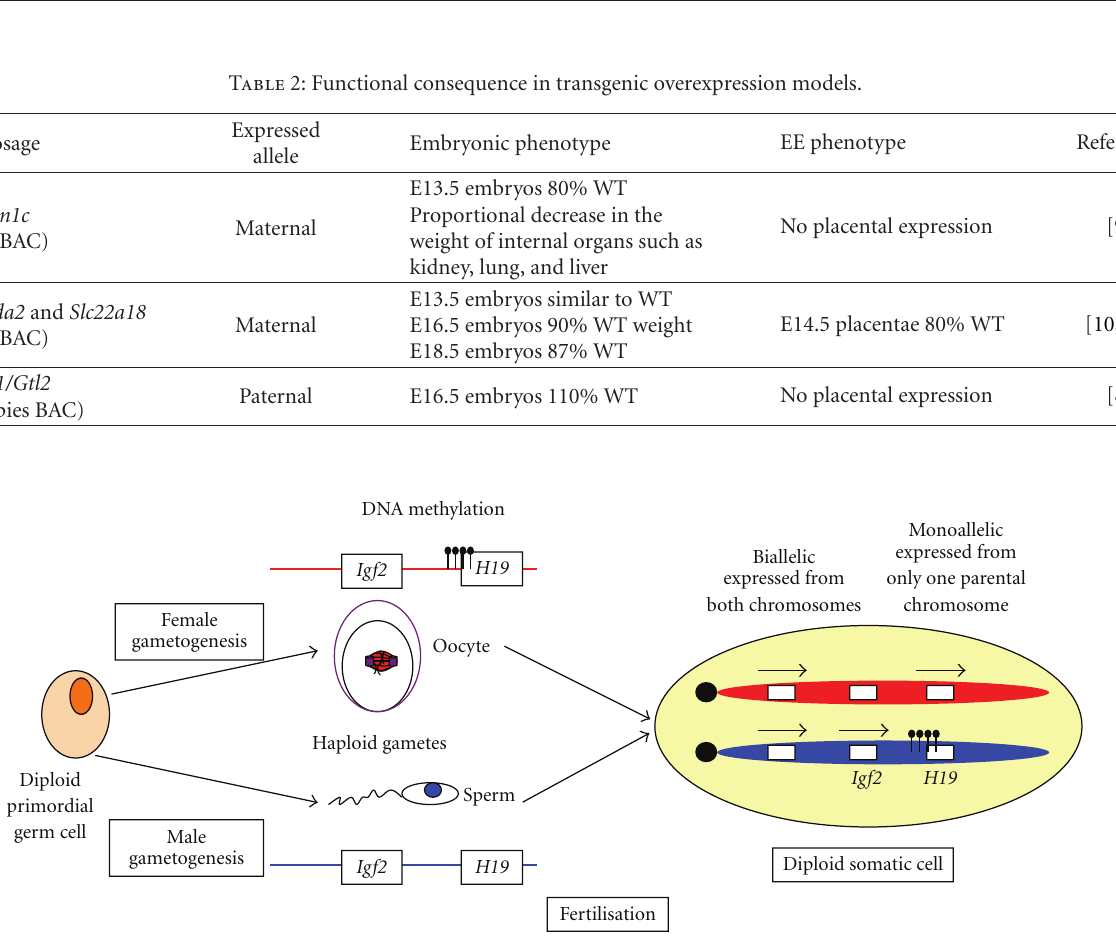
Figure 1: During mammalian gametogenesis, the diploid primordial germ cell undergoes meiosis to produce haploid male and female gametes. As meiosis progresses, specific DNA sequences acquire a DNA methylation imprint (black lollypops) in one parental germline but not the other. After fertilization, this imprint is recognized within the somatic cells establishing an imprinted domain. Maternal inheritance is indicated in red and paternal inheritance is indicated in